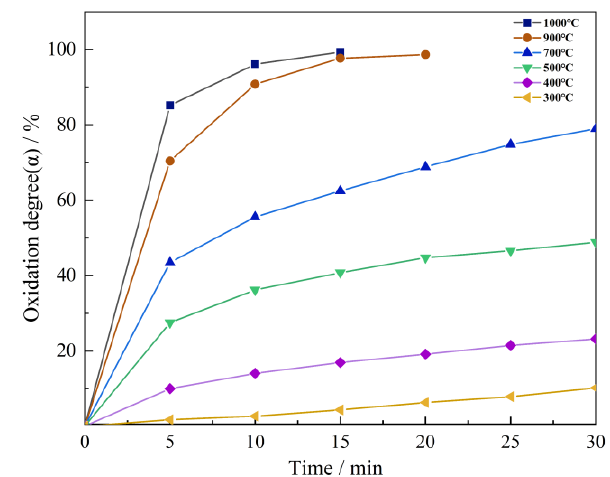
Figure 5. Fe oxidation rates of nickel slag samples after oxidation at different temperatures in different